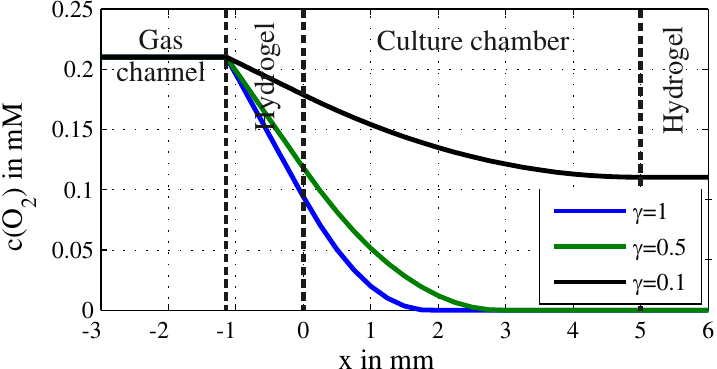
Figure 2. Course of the concentration of oxygen c ( O 2 ) in the steady state is shown for w Hg = 1.1mm, h = 0.38mm, A c = 400µm 2 , D = 2.4 × 10 − 9 m 2 filling factors γ